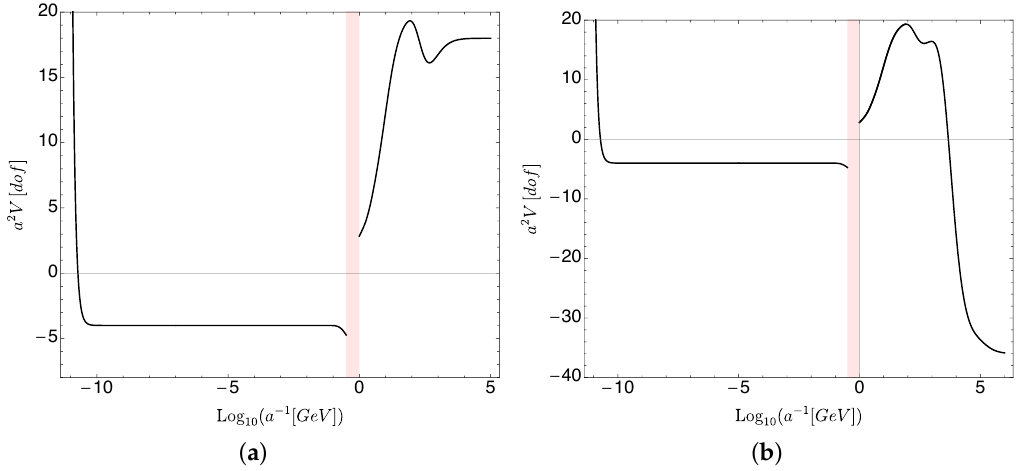
Figure 6. Figures taken from [98]. The red band indicates the region with energies around the QCD scale where no perturbative description is available. In analogy to the previous figures, the vertical axis shows the 3d scalar potential for the area modulus of the torus, V ( a ) , multiplied by a 2 to give a constant profile as a → 0, and normalized by the contribution of one degree of freedom. ( a ) Effective potential of the SM compactified in T 2 / Z 4 embedded into a discrete subgroup of the SU ( 3 ) colour Cartan subalgebra, where an AdS vacuum forms just below the QCD threshold. ( b ) Same plot for the MSSM, where the extra bosonic degrees of freedom create a runaway behaviour destabilizing the AdS vacua and rescuing the SM from the